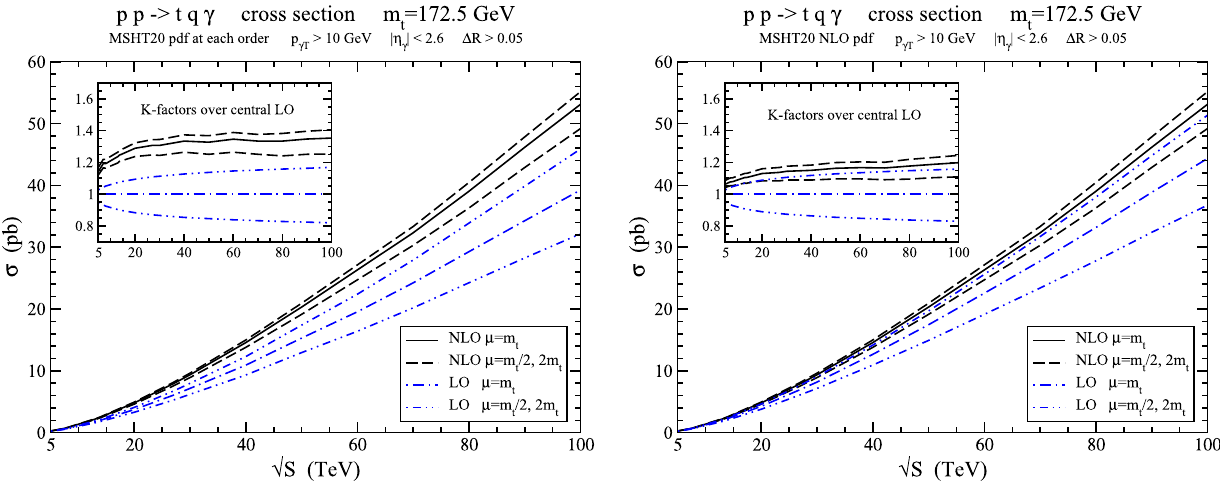
Fig. 2 The scale dependence of the LO and NLO total cross sections for tq γ production at pp colliders. In the left plot we use NLO (LO) pdf for the NLO (LO) cross sections while in the right plot we use NLO pdf for all